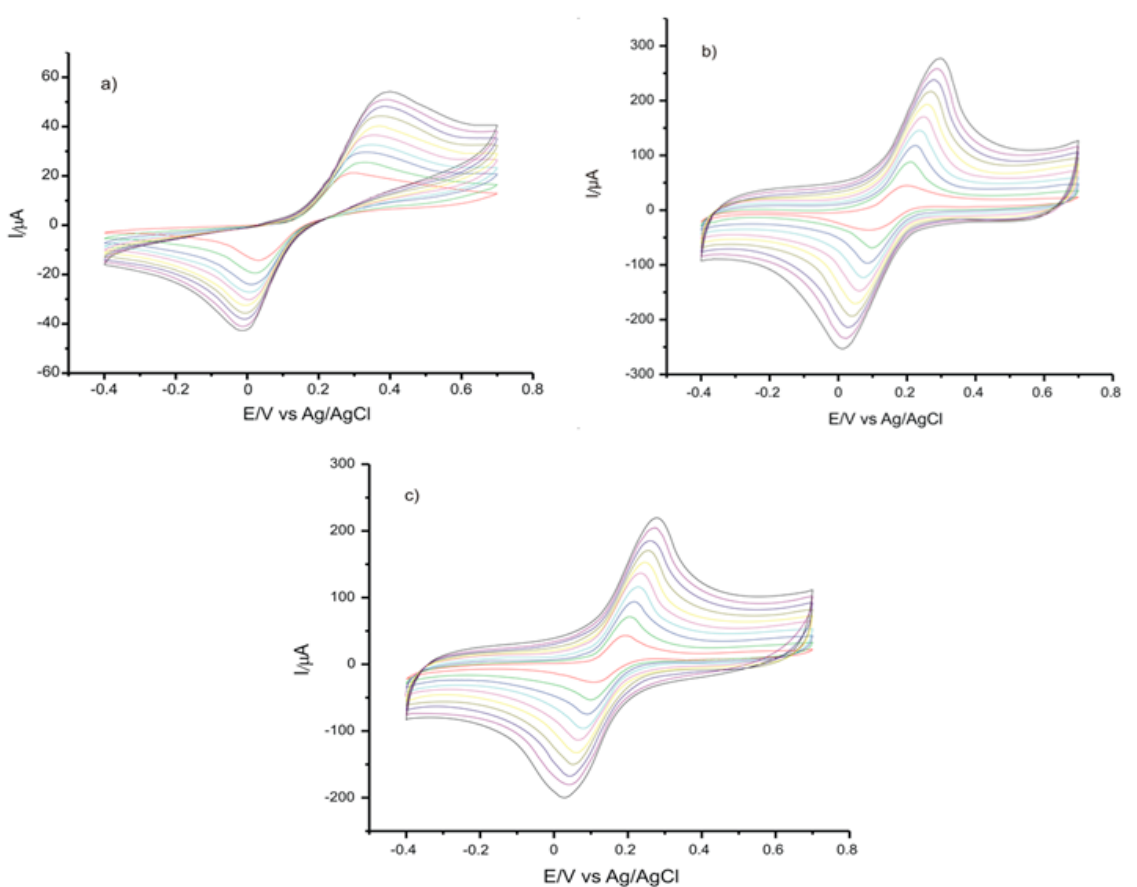
Figure 6. CVs of ( a ) C-SPE, ( b ) GPH-SPE, ( c ) GPH-GNP-SPE immersed in 10 − 3 M CGA solution, recorded at scan rates between 0.1 and 1.0 V·s − 1 .